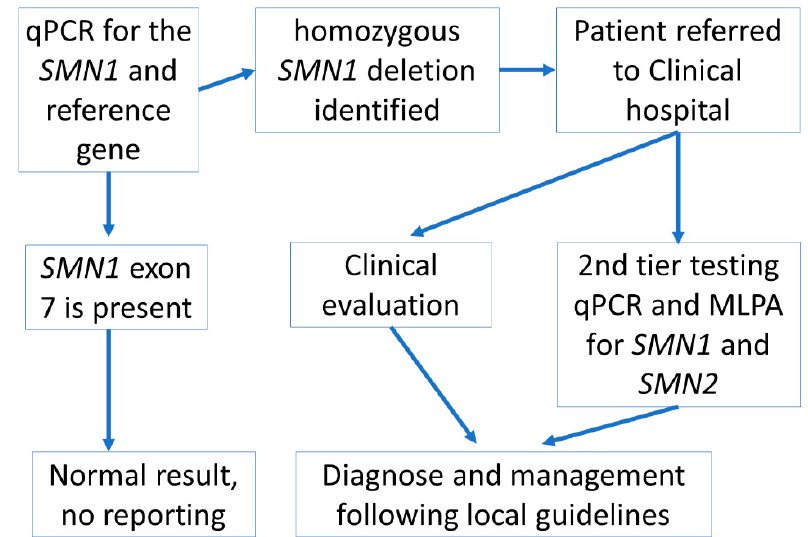
Figure 1. Screening algorithm used in the SMA pilot study in Latvia. If parents additionally agreed to the SMA screening test as well as the national NBS programme and provided signed informed consent, then the algorithm was initiated following DNA isolation from the DBS sample for the national NBS programme.